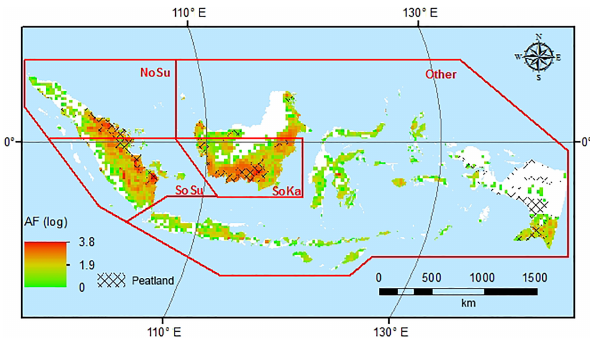
Figure 1. Region definition, number of active fires detected between 1997 and 2015 (log scale, rescaled to quarter degree) and peat- land extent for Indonesia. NoSu is northern Sumatra, SoSu south- ern Sumatra, and SoKa is southern Kalimantan. The white areas are where no active fires were